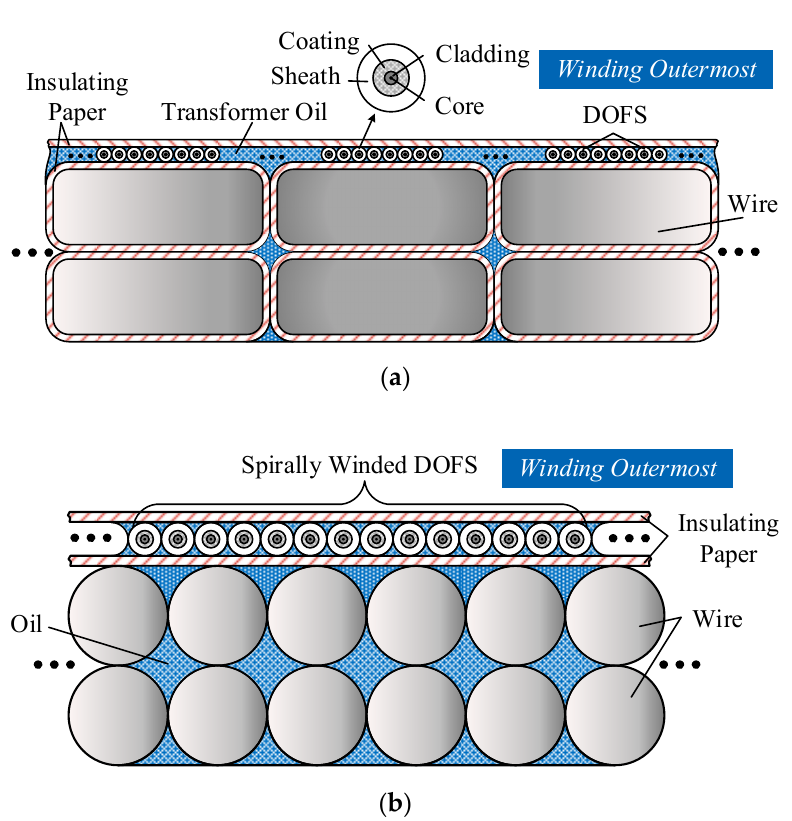
Figure 3. Fiber laying scheme (cross-section structure) on ( a ) low voltage (LV) winding; ( b ) high voltage (HV) winding.